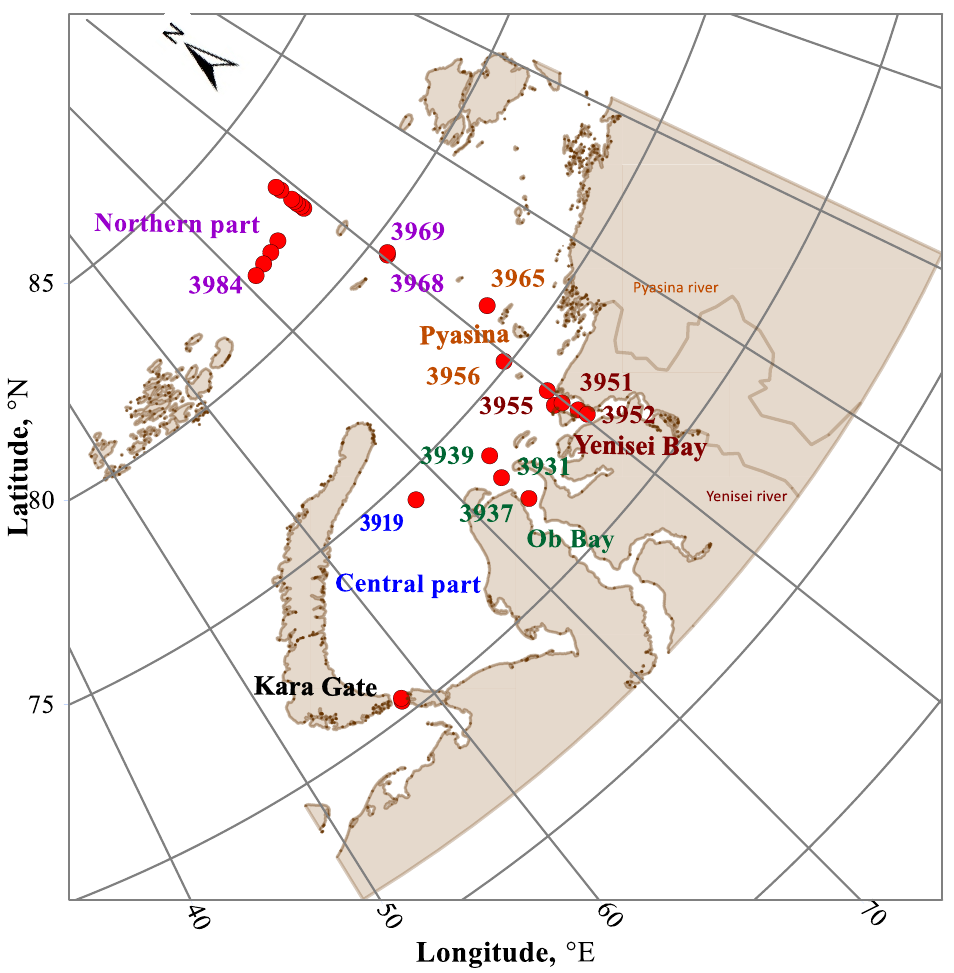
Figure 1. Stations of the 58th cruise of R/V “Academik Ioffe” with the optical measurements. The numbers indicate the stations that will be mentioned later in this article.